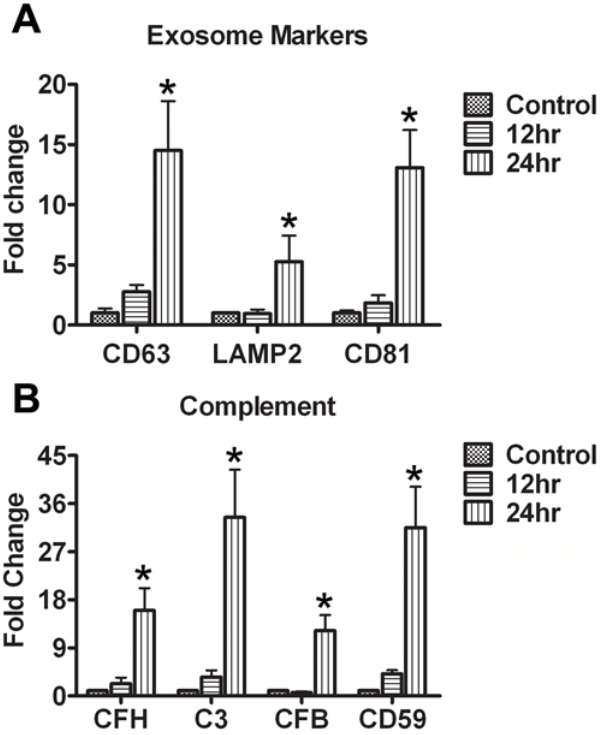
Figure 5. Exosome markers and complement in ARPE-19 cells. ( A ) When the cells were treated with 10 m M B(a)P for 24 hr to damage their mtDNA, gene expression of exosome markers CD63, CD81 and LAMP2 was significantly increased at 24 hrs ( p , 0.05, n=3). ( B ) When the cells were treated with 10 m M B(a)P for 24 hr to damage their mtDNA, gene expression of complement pathway components CFH, C3, CFB and CD59 was significantly increased at 24 hrs (p , 0.05, n=3).